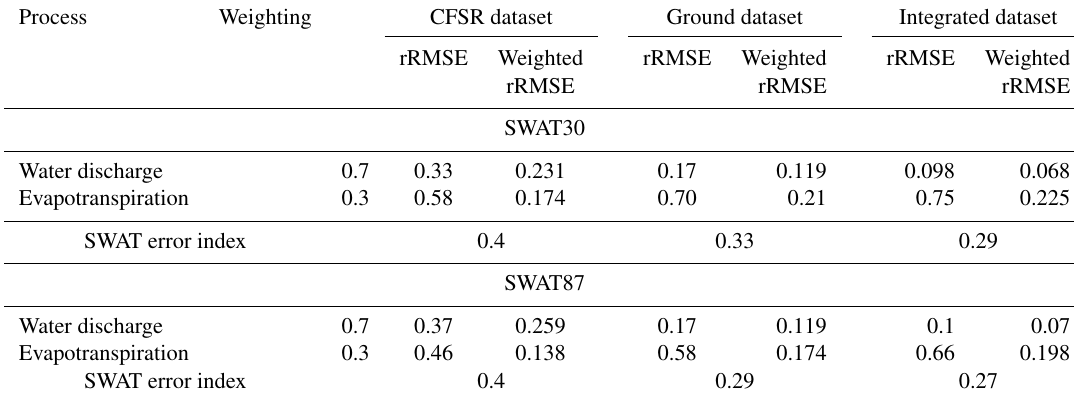
Table 5. SEI results for the upper Blue Nile Basin.